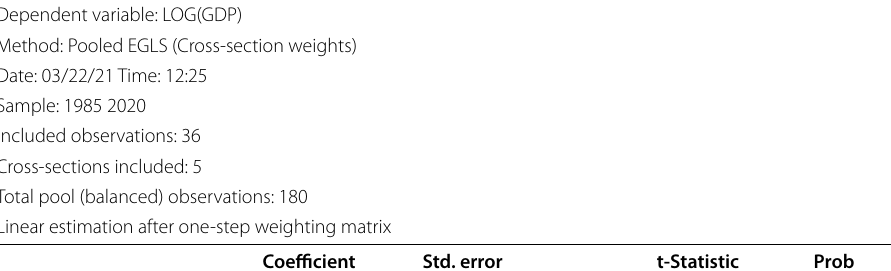
Table 2 Results of the specific estimation of Eq. 3 on panel